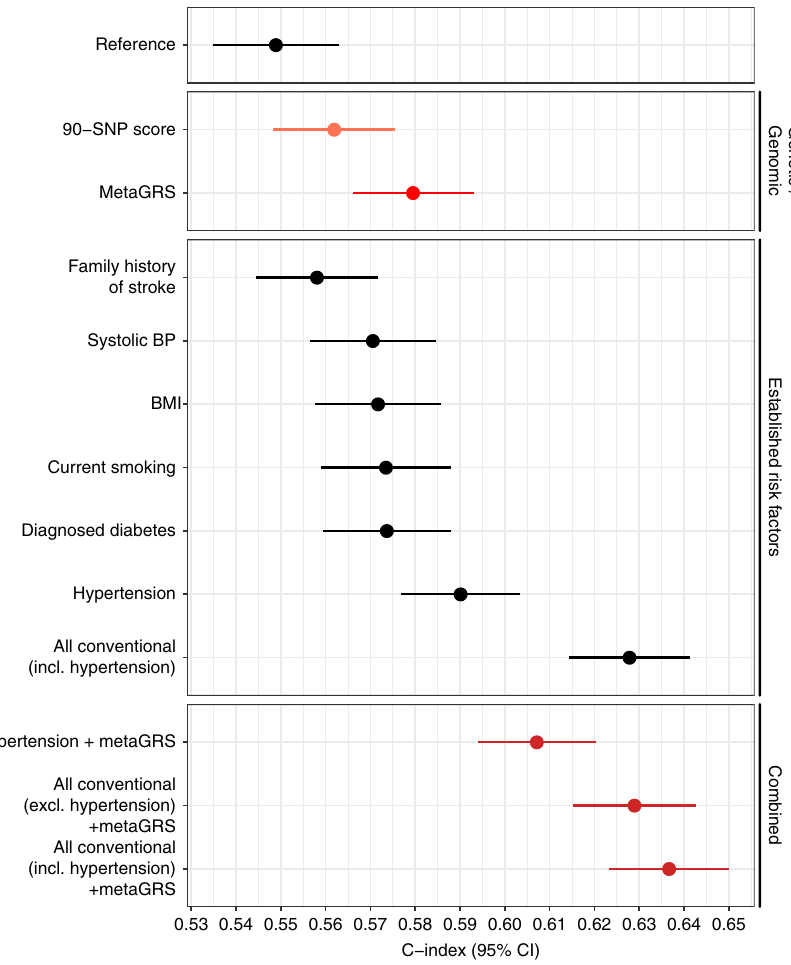
Fig. 4 The metaGRS for ischaemic stroke has comparable or higher predictive power than established risk factors. Shown are the C-indices for incident stroke in the UKB validation set comparing the metaGRS with established risk factors. The reference model included the genotyping chip and 10 genetic PCs. Results are for the UKB validation set, excluding prevalent stroke events ( n = 390,849). Red circles represent genetic/genomic scores; black circles represent non-genetic scores. Error bars represent 95% con fi dence